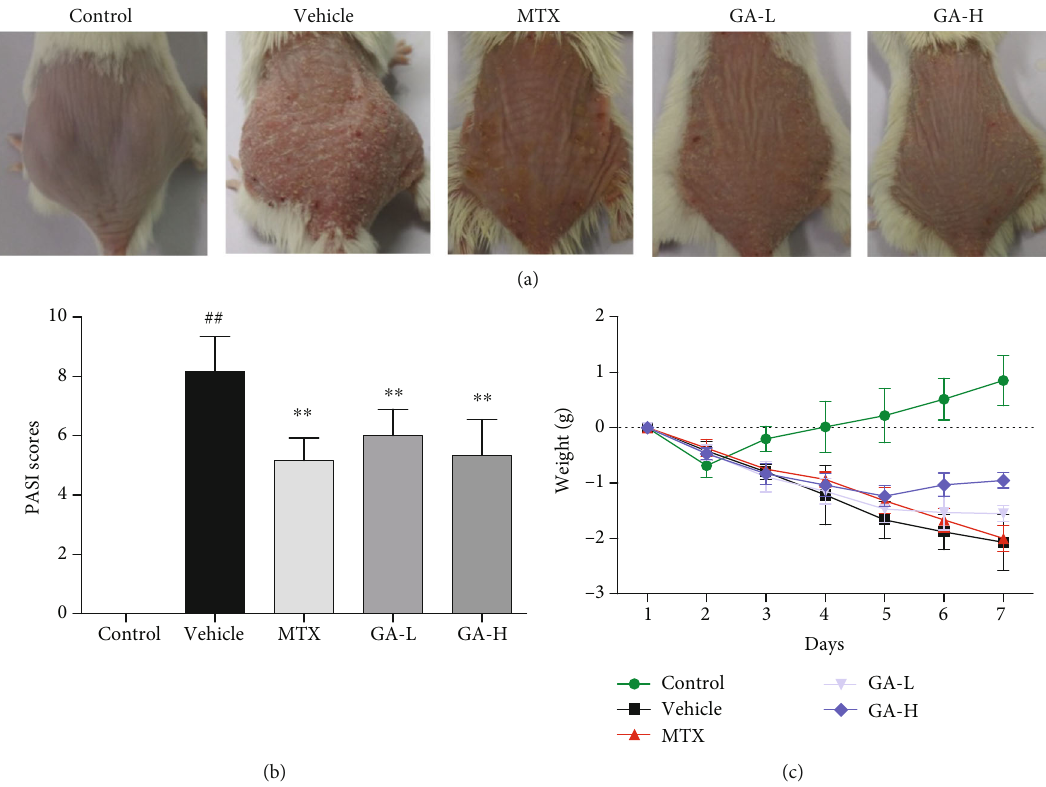
Figure 2: GA reduces the PASI score and ameliorates the skin lesion in IMQ-induced psoriasis-like mice. (a) The representatives of photos of dorsal skin in IMQ-induced psoriasis-like mice 7 days after IMQ-treatment without or with GA. (b) The PASI scores of the skin lesion in IMQ-induced psoriasis-like mice after treatment. (c) The daily mouse weight during the treatment. Data are presented as the means ± SD ( n = 6 , # P < 0 : 05 and ## P < 0 : 01 vs. control group, ∗ P < 0 : 05 and ∗∗ P < 0 : 01 vs. vehicle group). (GA-L: low-dose of GA; GA-H: high-dose of